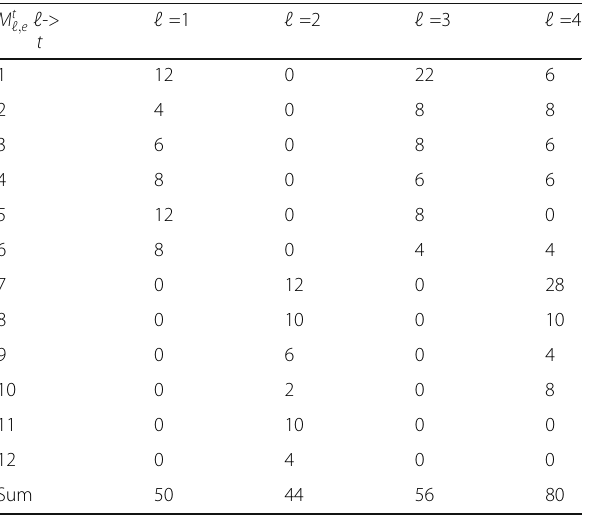
Table 4 No. of servers per type per rack of POD